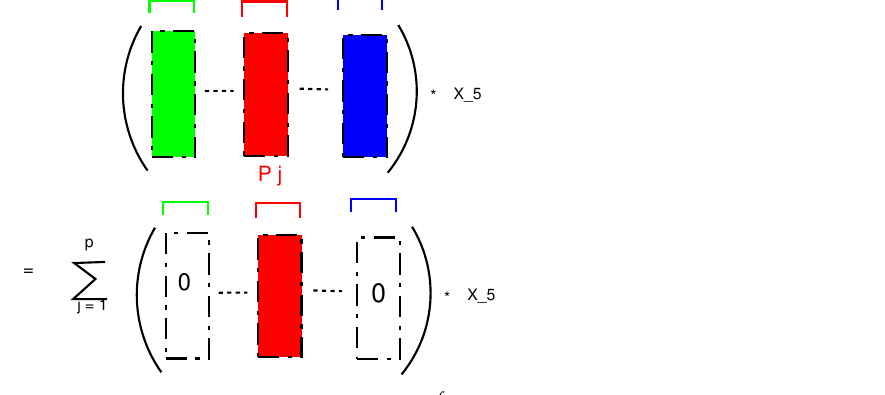
Figure 3. The matrix multiplication of Y f and X 5 in case N e > p . P i ( i =1, · · · , p ) denotes the i th processor.